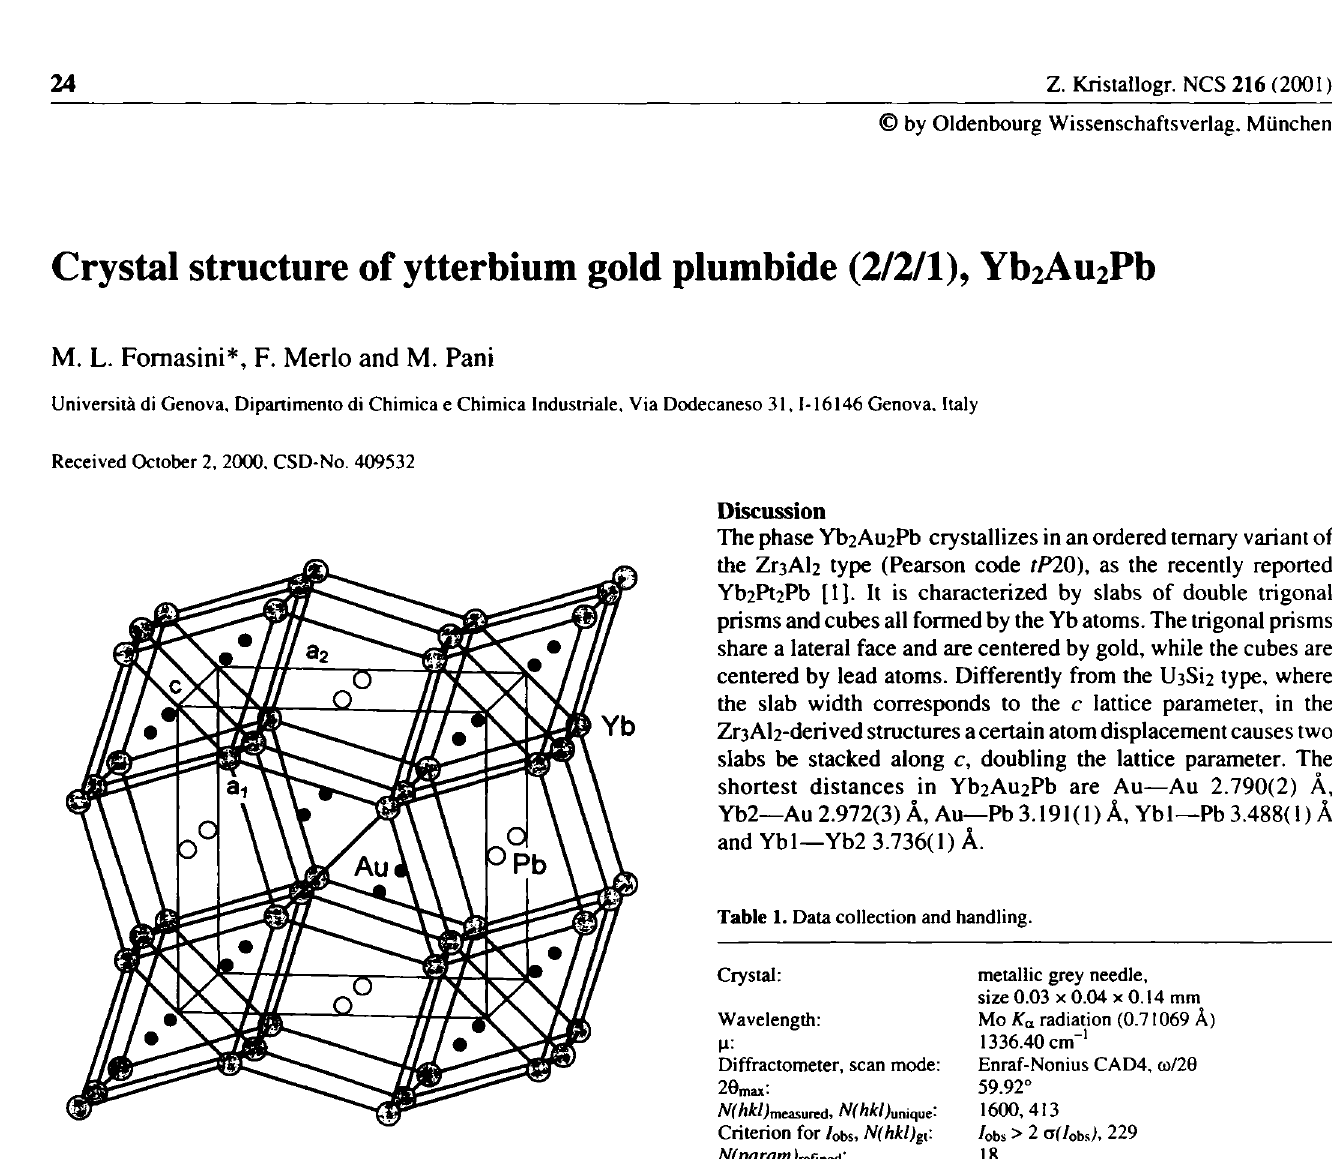
Table 1. Data collection and handling.